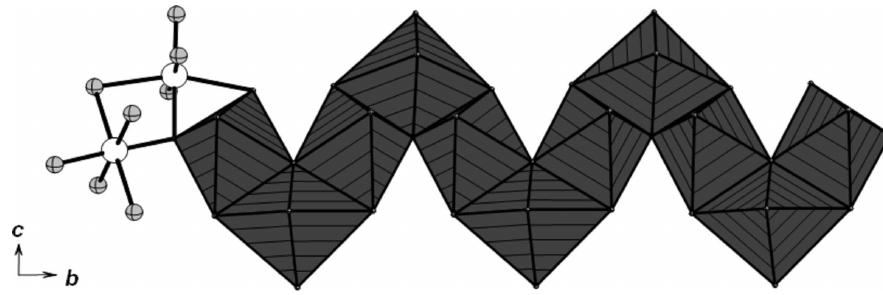
polyhedra along the b -axis. Polyhedra are shaded in 6